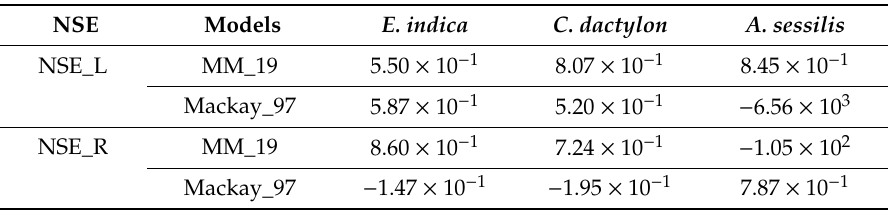
Table 2. E ffi ciency of MM_19 and Mackay_97